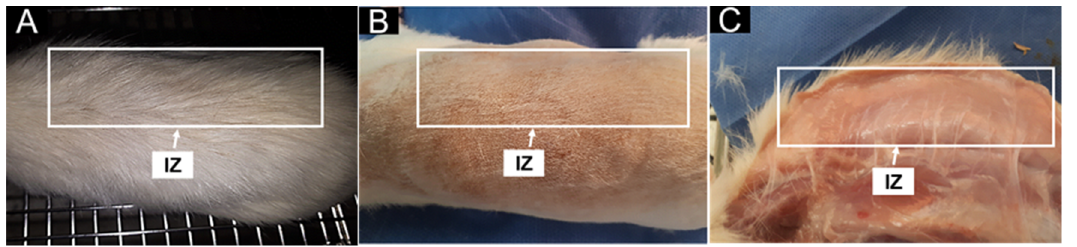
Figure 6. Macroscopic observation of the dorsal area of the biomodel 30 days after implantation. ( A ): Hairy surface. ( B ): Surface after trichotomy. ( C ): The inner surface of the skin. IZ: Implantation zone.